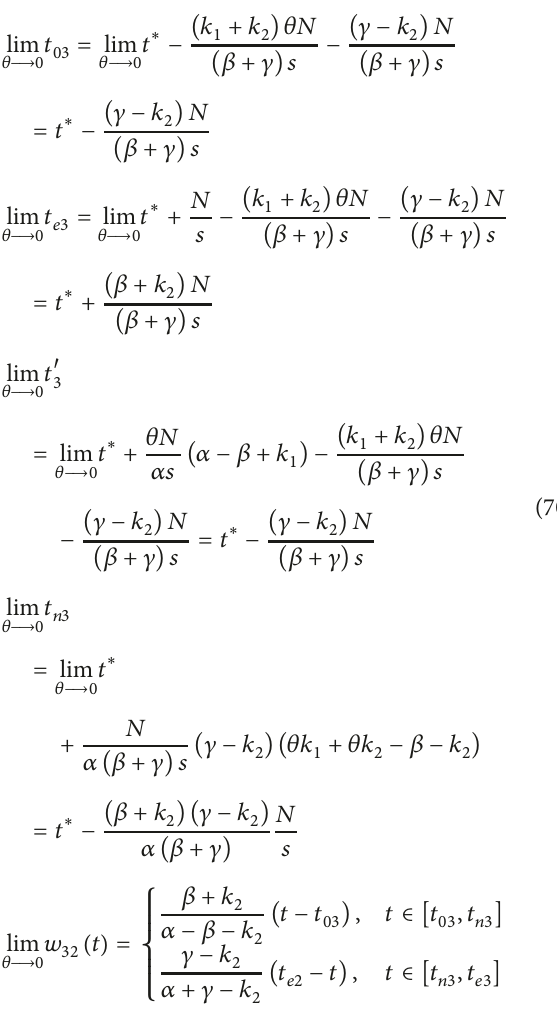
travelers and negative travelers follows the personal perception bottleneck model based on negative